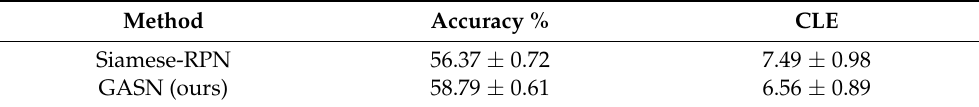
Table 10. The statistical analysis of the tracking